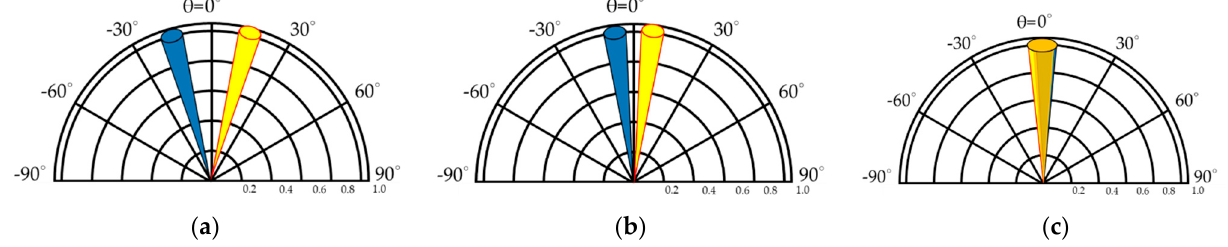
Figure 11. The far-field distribution for the bi-directional OPA is simulated through FDTD at different input wave- lengths. ( a ) The operating wavelength is 1510 nm, and the vertical scanning angle is turned to +15 degrees and − 15 de- grees, respectively. ( b ) The operating wavelength is 1550 nm, and the vertical scanning angle is maintained at 8.4 de- grees. ( c ) The wavelength is 1600 nm, and the vertical scanning angle is turned to − 0.8 degrees and +0.8 degrees, respec- tively.